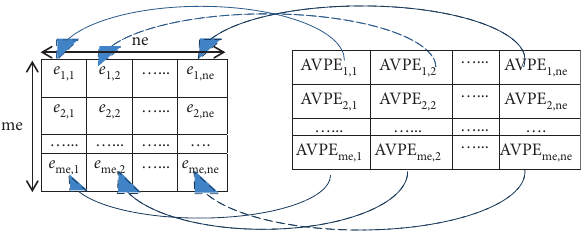
Figure 4: Overview of AVPEs agents data initialization.